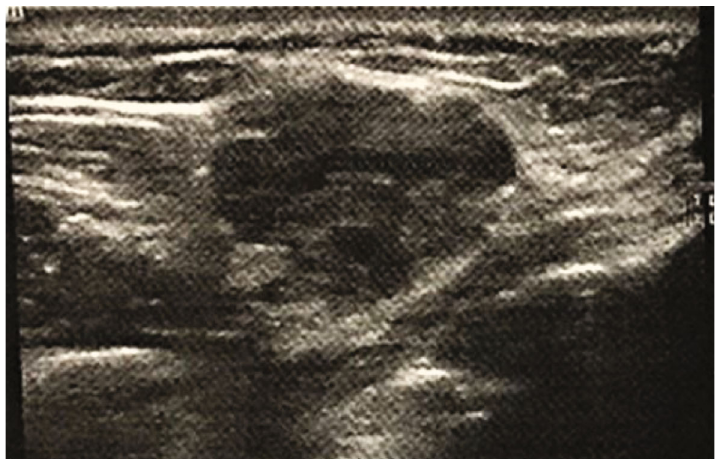
Figure 1: Ultrasonography shows a well-de fi ned hypoechoic heterogenous mass lying between the skin and buccinator muscle.